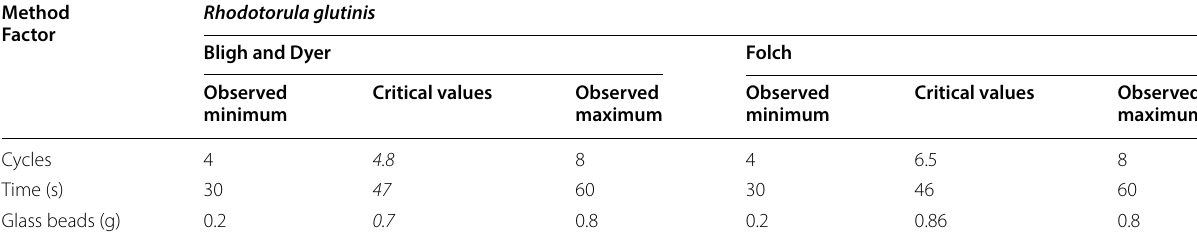
Table 3 Estimated optimum extraction conditions for the yeast Rhodotorula glutinis using the Bligh and Dyer and Folch